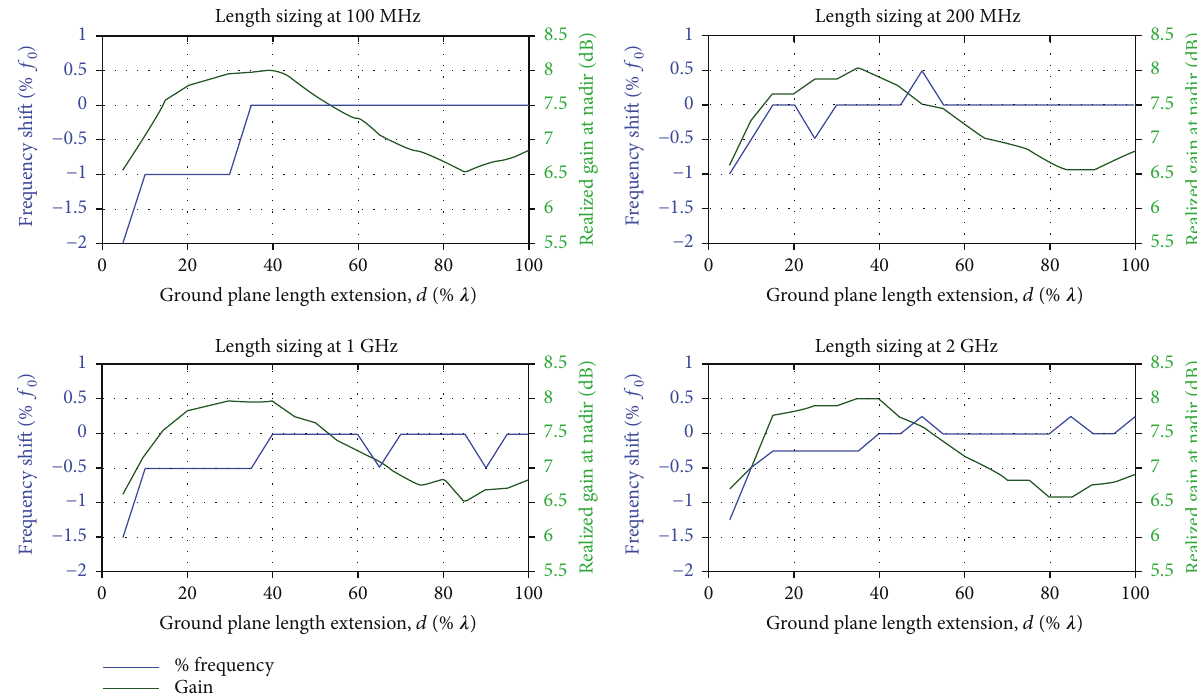
Figure 6: Ground plane length extension versus frequency shift and realized gain at nadir plot for all operating